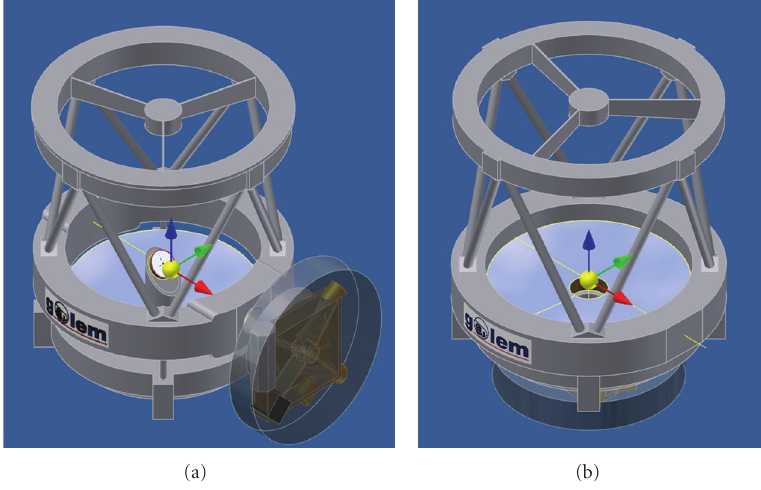
Figure 3: The two Nasmyth (a) and Cassegrain (b) Instrument